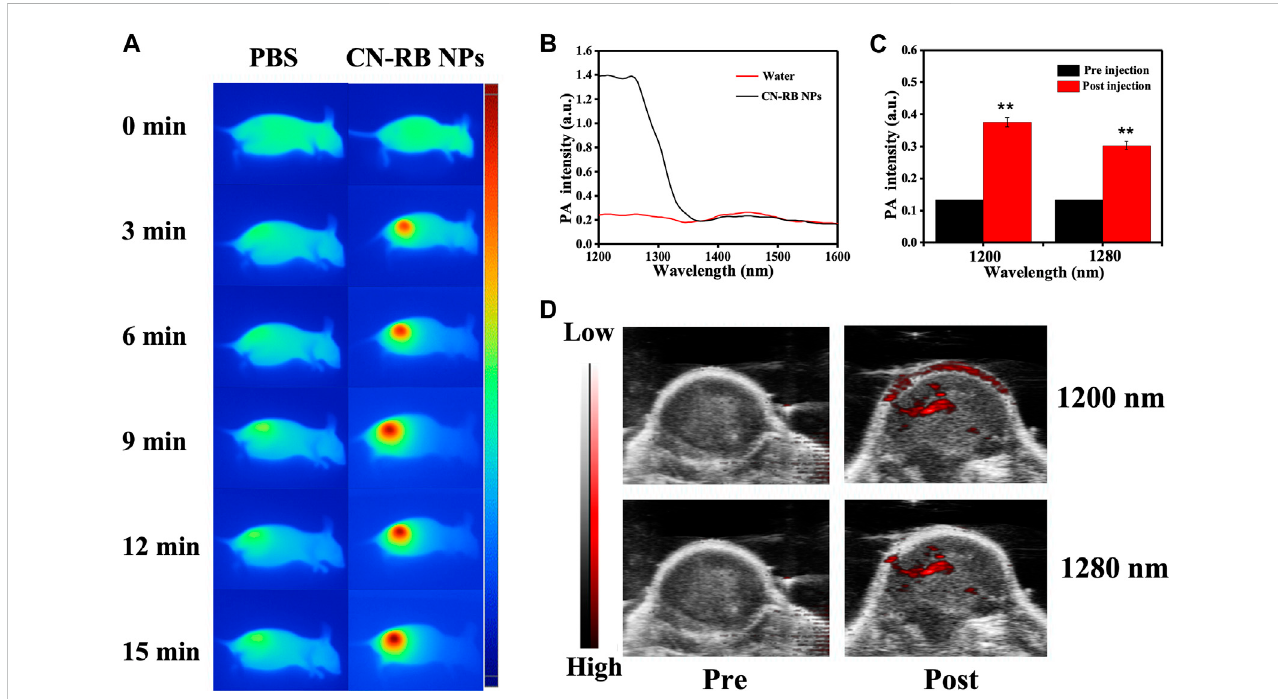
FIGURE 3 (A) Infraredthermalimagingof4T1-tumor-bearingBLAB/cnudemiceinjectedwithPBSorCN-RBNPsafterirradiationat1064 nm(2 W cm − 2 )for15 min (B) In vitro PA signal of CN-RB NP solution from 1200 to 2000 nm. (C) At 1200 nm and 1280 nm, in-vivo- quanti fi ed PA signal of tumors pre-injection and post-injection of CN-RB NPs. (D) In vivo PA images pre-injection and post-injection of CN-RB NPs at 1200 nm and 1280